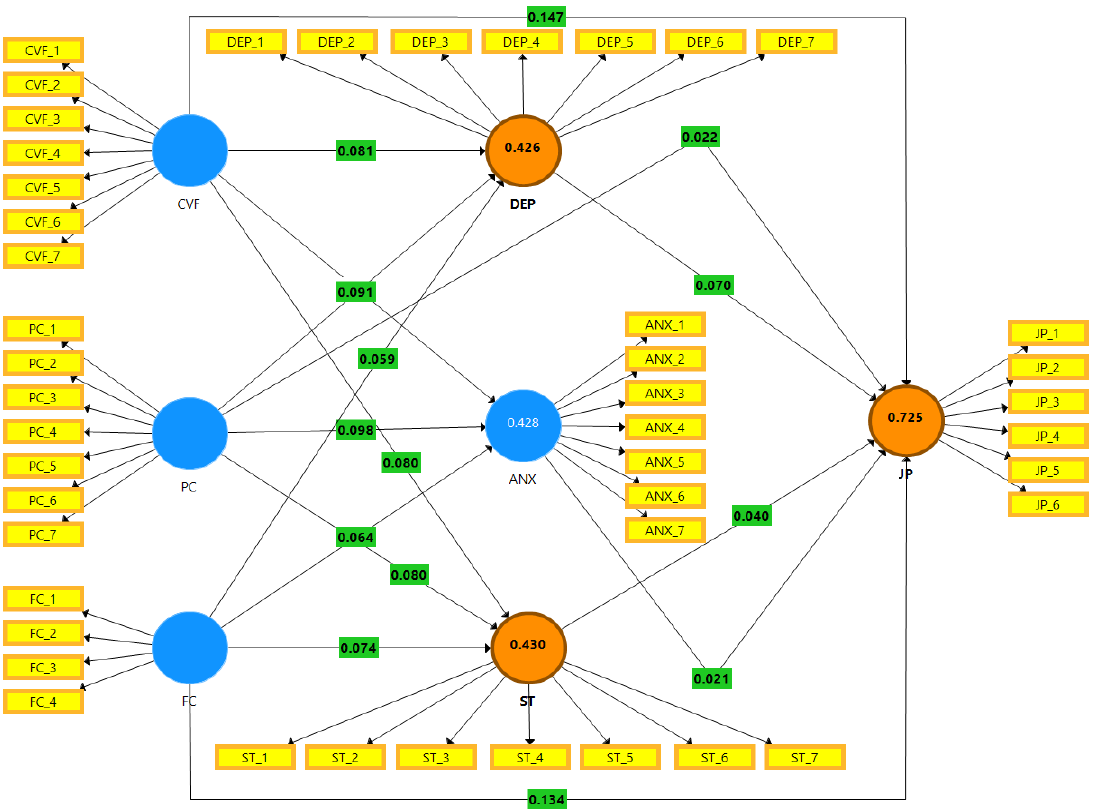
Figure 4. Graphical representation of R 2 and f 2.